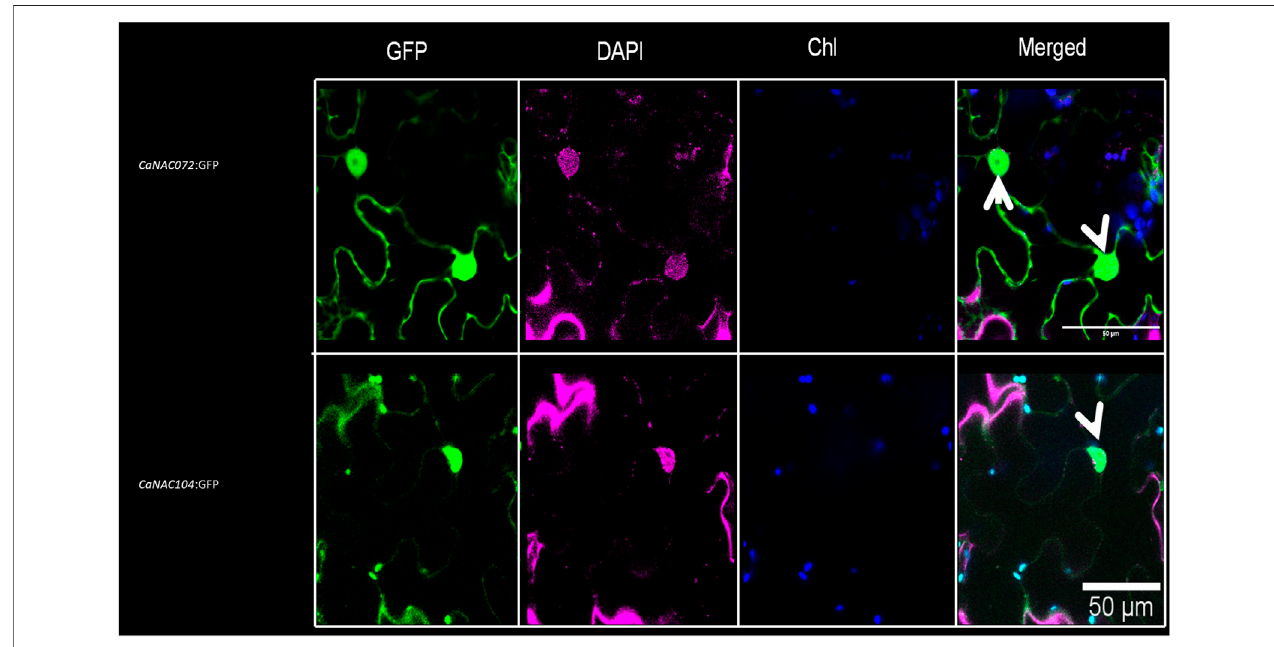
FIGURE 5 | Nuclear localization of CaNAC072 and CaNAC104. Confocal microscopy analysis showing the nuclear localization of CaNAC072:GFP and CaNAC104:GFP upon transient expression in Nicotiana benthamiana leaves. Nuclear-speci fi c staining using DAPI con fi rmed nuclear localization of both TFs. “ Merged ” indicates the combination of GFP and chlorophyll (Chl) auto fl uorescence signals. White arrows indicate the nuclear-speci fi c GFP signal. Scale bar, 50 μ